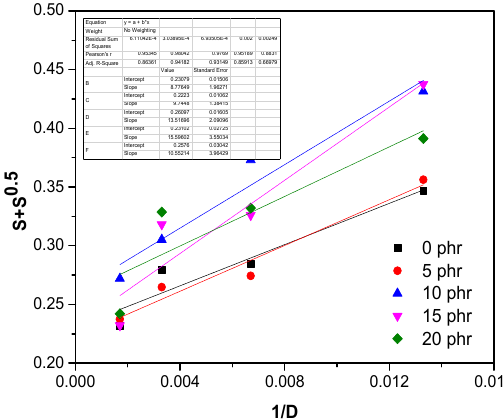
Figure 9. Charlesby–Pinner plots of EPDM/hemp samples. Table 3. Compositional characteristics, designation and p 0 /q 0 ratio for EPDM and EPDM/hemp samples.